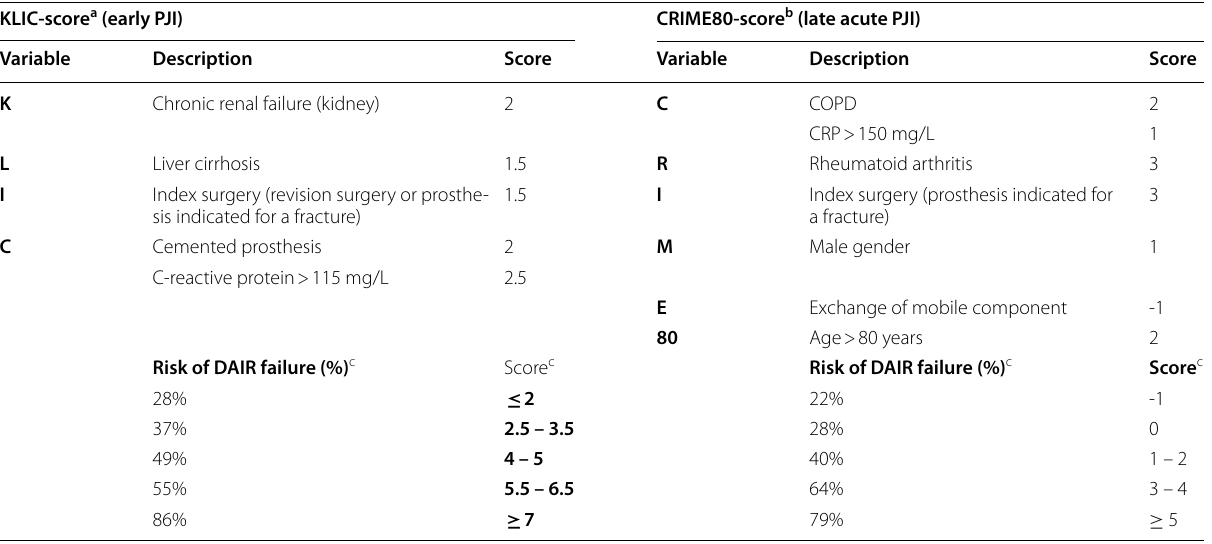
a Based on a cohort of early acute PJI patients in Medical Center Leeuwarden, Martini Hospital and University Medical Center Groningen ( n b Based on a cohort of late acute PJI patients in an international multicentre study ( n c In case of S. aureus , the risk of failure with a score of -1 is already